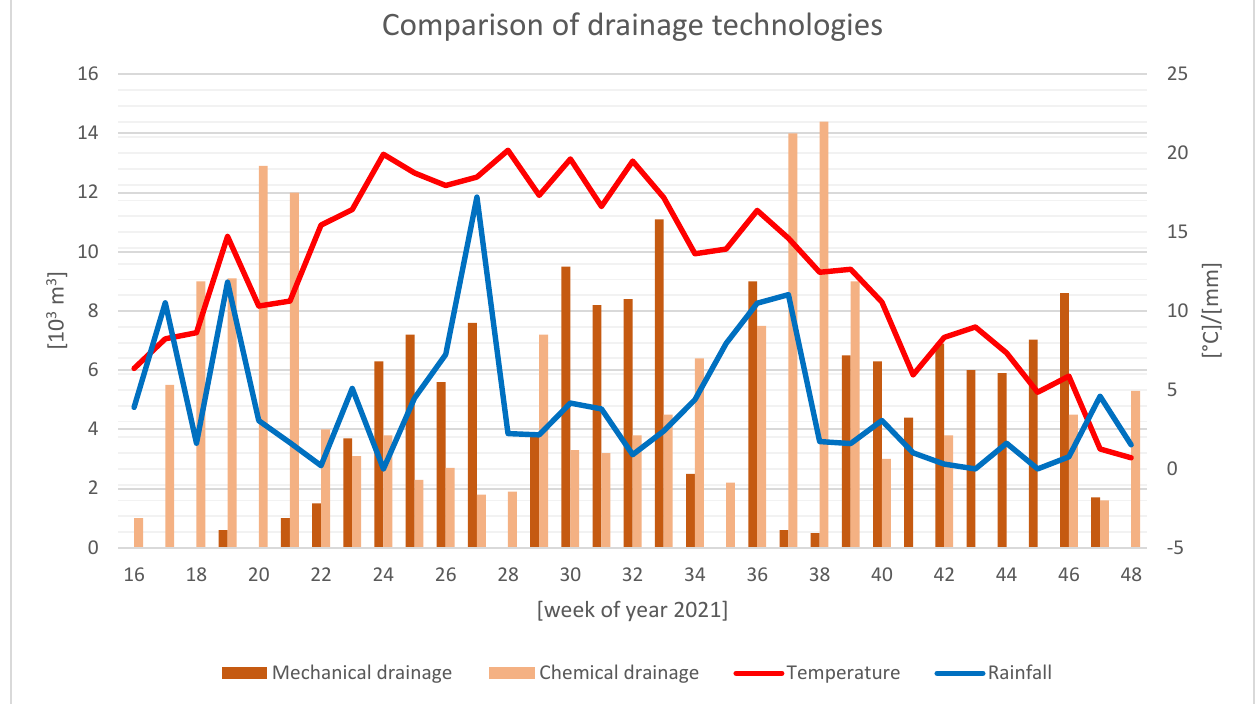
Figure 8. The efficiencies of the analysed soil drainage technologies as well as average daily temperatures and precipitation (internal analysis based on reports of the project contractor and [51]).